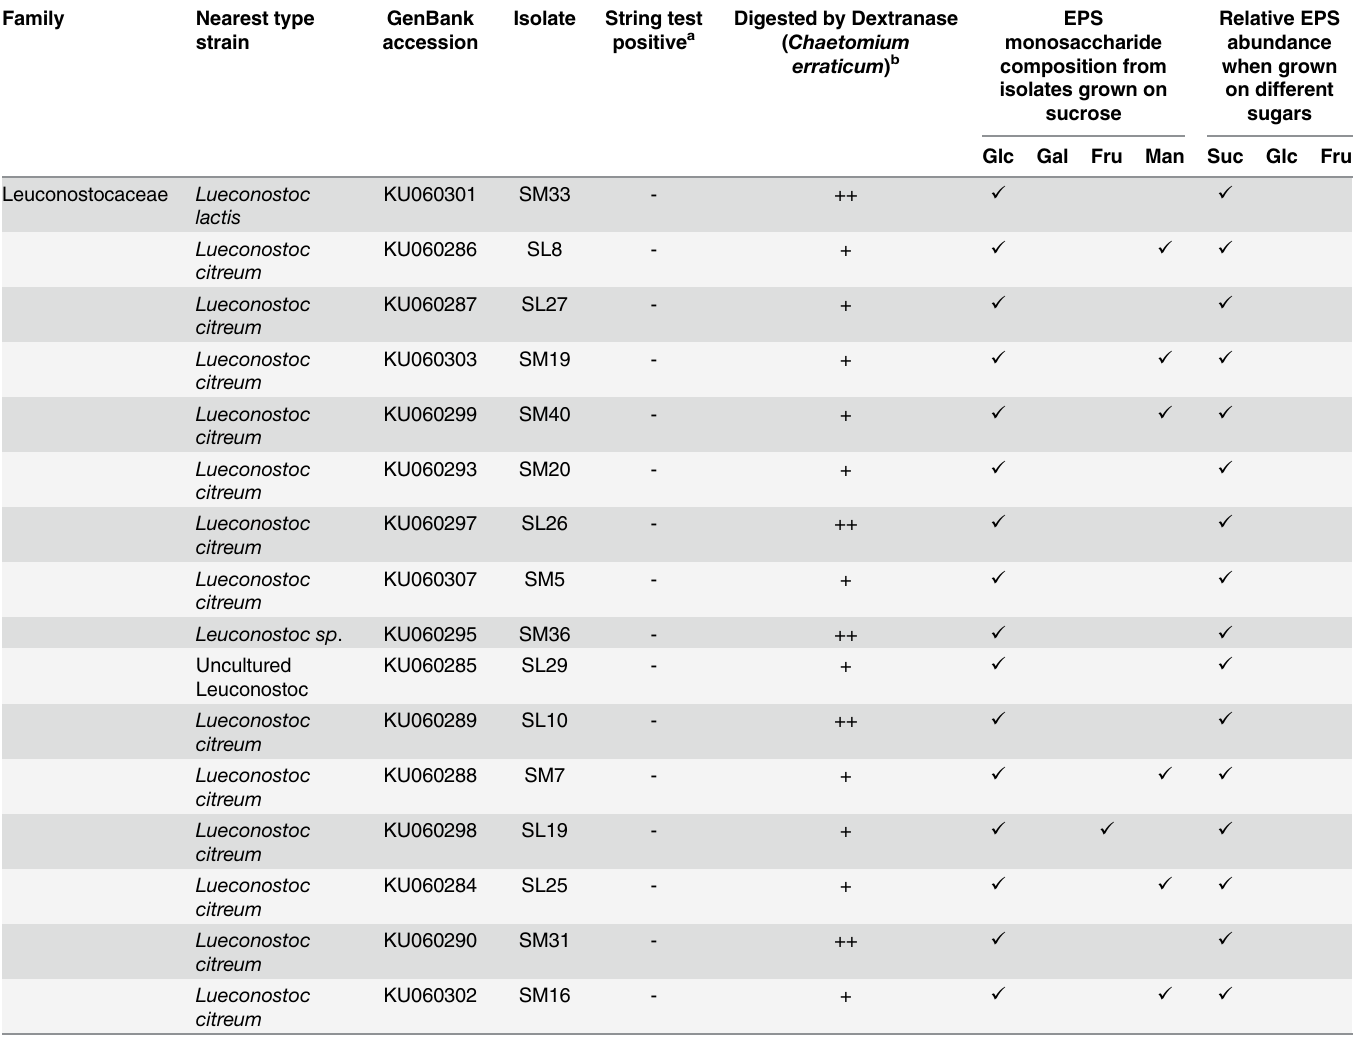
Table 1. EPS producing isolates nearest type strains, GenBank accession, string test results, monosaccharide composition, dextranase suscepti- bility and relative polysaccharide abundance are shown. Family Nearest type GenBank Isolate String test strain accession positive